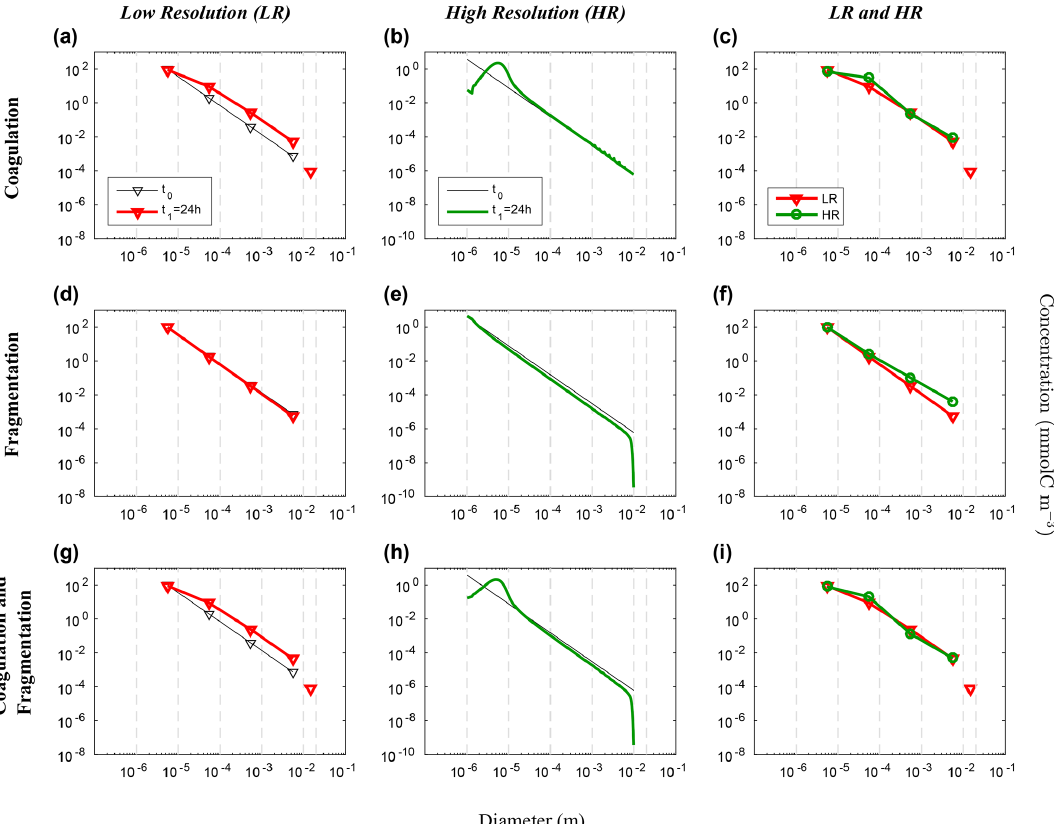
Figure 8. Evolution of the carbon concentration distribution over the size range in our nonlinear size discretization configuration (E2) as function of diameters when the function reducing resolution dependency is implemented (Eq. 27). Our three sets of reaction simulations are represented: coagulation only ( a–c ), fragmentation only ( d–f ) and when both reactions are combined ( g–i ). The left column (a,d,g) represents our LR setup, the middle column (b,e,h) the HR one and the right column (c,f,i) the comparison of the HR carried back to LR (see Eq. 25 in Sect. 3.1 for details). For each panel, the initial time step t 0 is in black and the final time step t 1 = 24h appears in red for LR and in green for HR. For further details, refer to the legend of Fig.